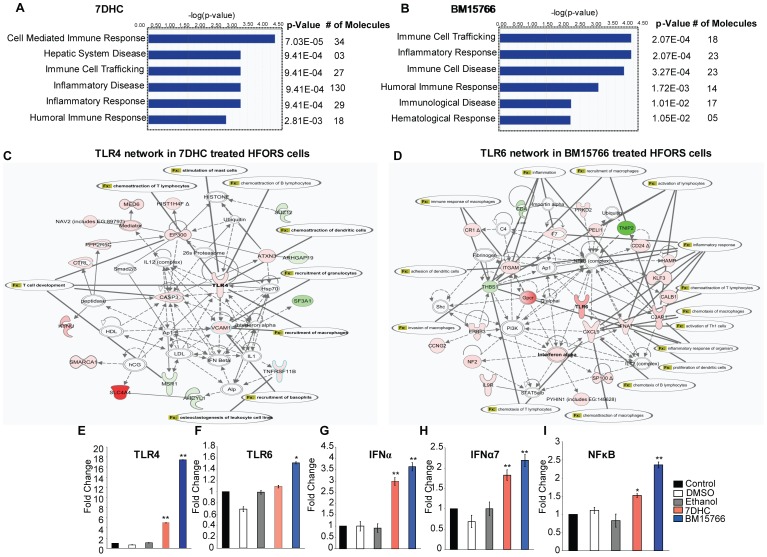
Sterol intermediates of cholesterol biosynthesis trigger an inflammatory response in hair follicle cells.Inflammatory and immune responses were the top biological functions affected by treatment of HHFORS cells with (A) 7-DHC or (B) BM15766. The most significant biological functions affected, their p values and the number of differentially expressed genes (molecules) after each treatment were identified using IPA. The difference between vehicle and 7-DHC or BM15766 treatments was defined as significant if a 1.5-fold or greater difference in the average hybridization signal intensity with a p<0.05 using a two-tailed unpaired t-test was observed. Predicted interaction networks in hair follicle cells after treatment with (C) 7-DHC and (D) BM15766 are shown. The TLR4 gene network was activated after 7-DHC treatment, and the TLR6 network was activated after BM15766 treatment. Solid lines denote a direct relationship, and dotted lines denote an indirect relationship between two genes in the network. A red node denotes an upregulated gene, and a green node denotes a downregulated gene, with the difference in intensity reflecting the degree of change in the expression of differentially expressed genes in our dataset. The inflammatory functions and disease (fx) associated with each TLR network were determined using IPA. See also Table S3. The real-time PCR validation of (E) TLR4, (F) TLR6, (G) IFNα, (H) IFNα7 and (I) NFkB gene expression in 7DHC- and BM15766-treated hair follicle cells (*p<0.05, **p<0.01) is shown. The unpaired t-test was used for statistical analysis.